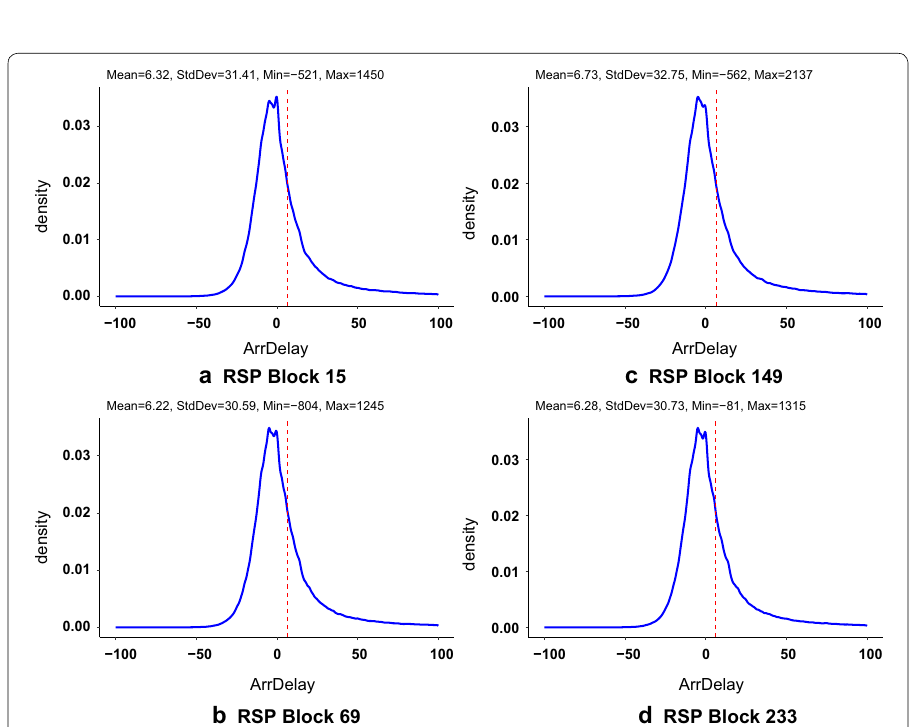
Fig. 14 Exploring the data distribution in AirOnTime87to12. Density plots of ArrDelay in 4 RSP blocks from AirOnTime87to12